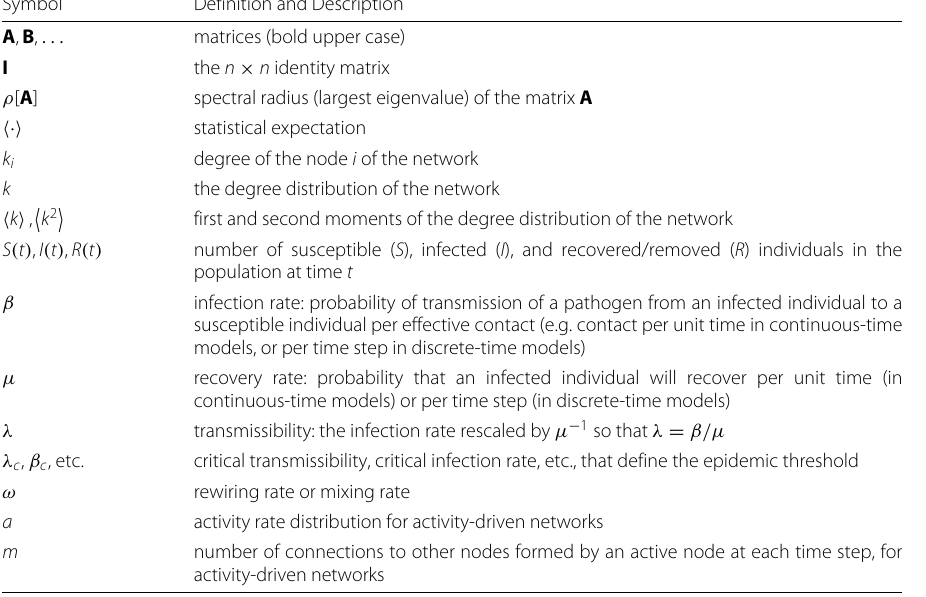
Table 1 Common Symbols